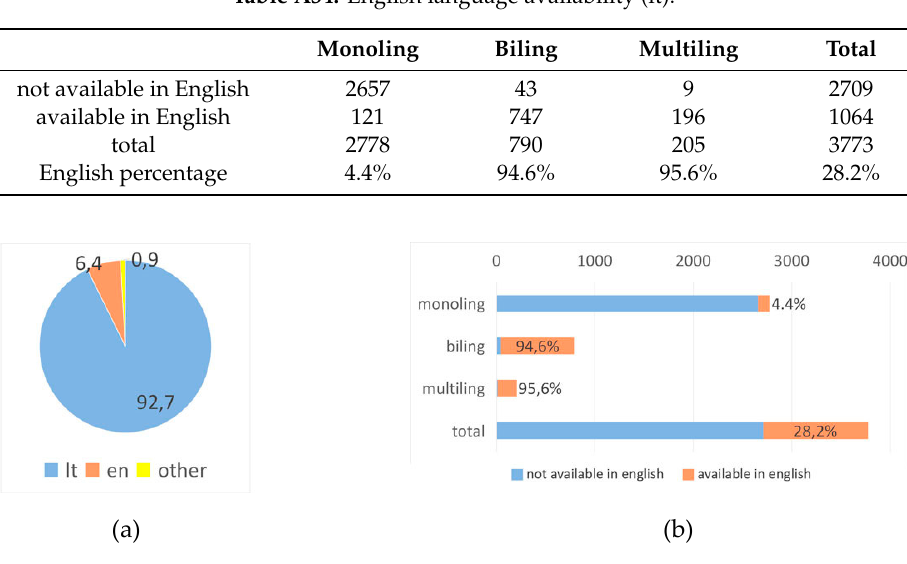
Figure A17. Visualization of the results for domain lt. ( a ) Primary languages pie chart and ( b ) English language availability bar chart.